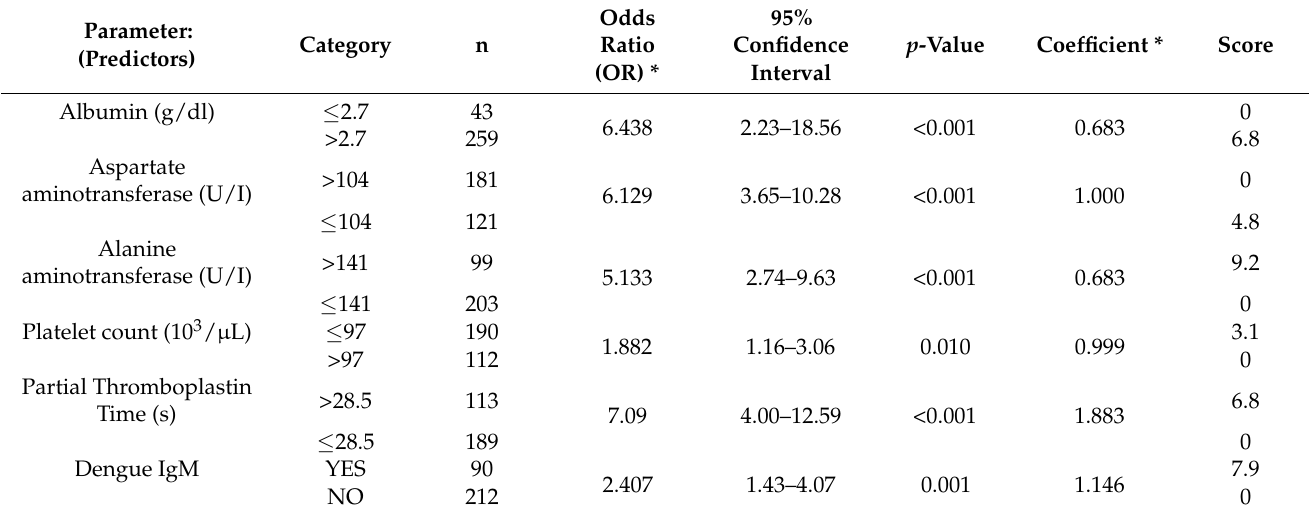
Table 1. Significance of factors for predicting severe dengue fever infection.